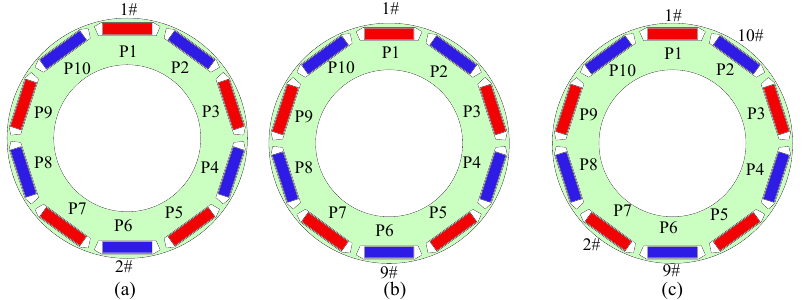
Figure 7. Three different PM assembling methods from E 2 to E 4 , where the particular number of PMs and their assembling position highlighted, while the unlabelled positions would be filled in with randomly selected PMs. ( a ) The assembling approach E 1 , ( b ) the assembling approach E 2 , ( c ) the assembling approach E 3